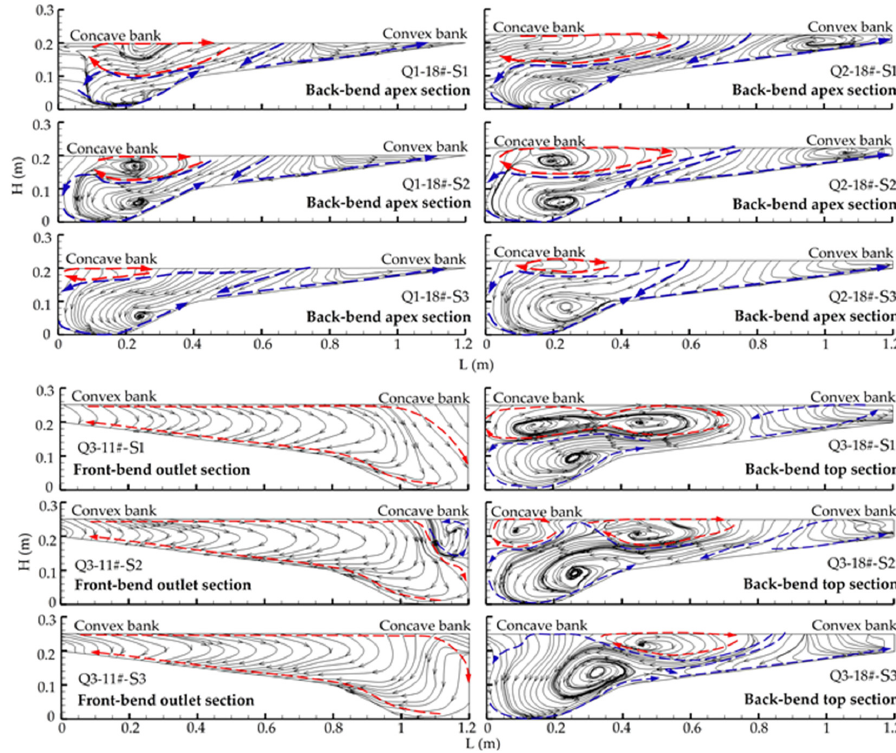
Figure 4. Circulation structure distribution of the typical cross-sections under different scenarios and discharges. The direction of the arrow in the typical section is the flow direction. The red and blue dotted lines denote the clockwise and anticlockwise circulation structure, respectively.